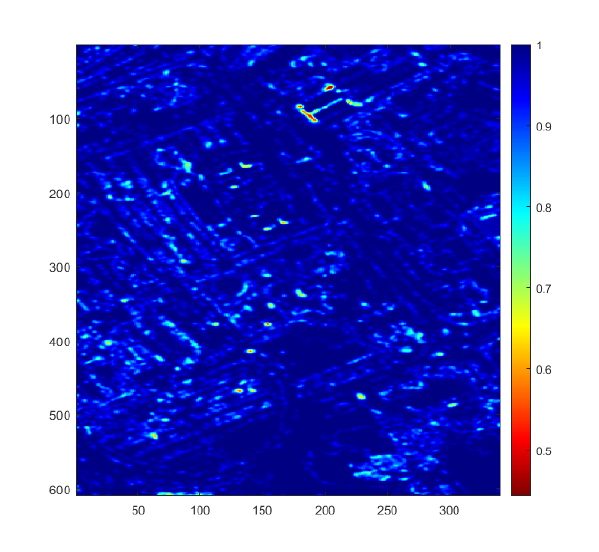
Figure 15. Pavia University difference